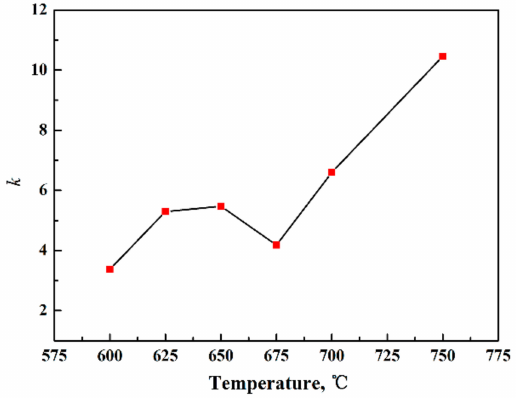
Figure 8. Plots of the k parameter of samples intercritical annealing at different